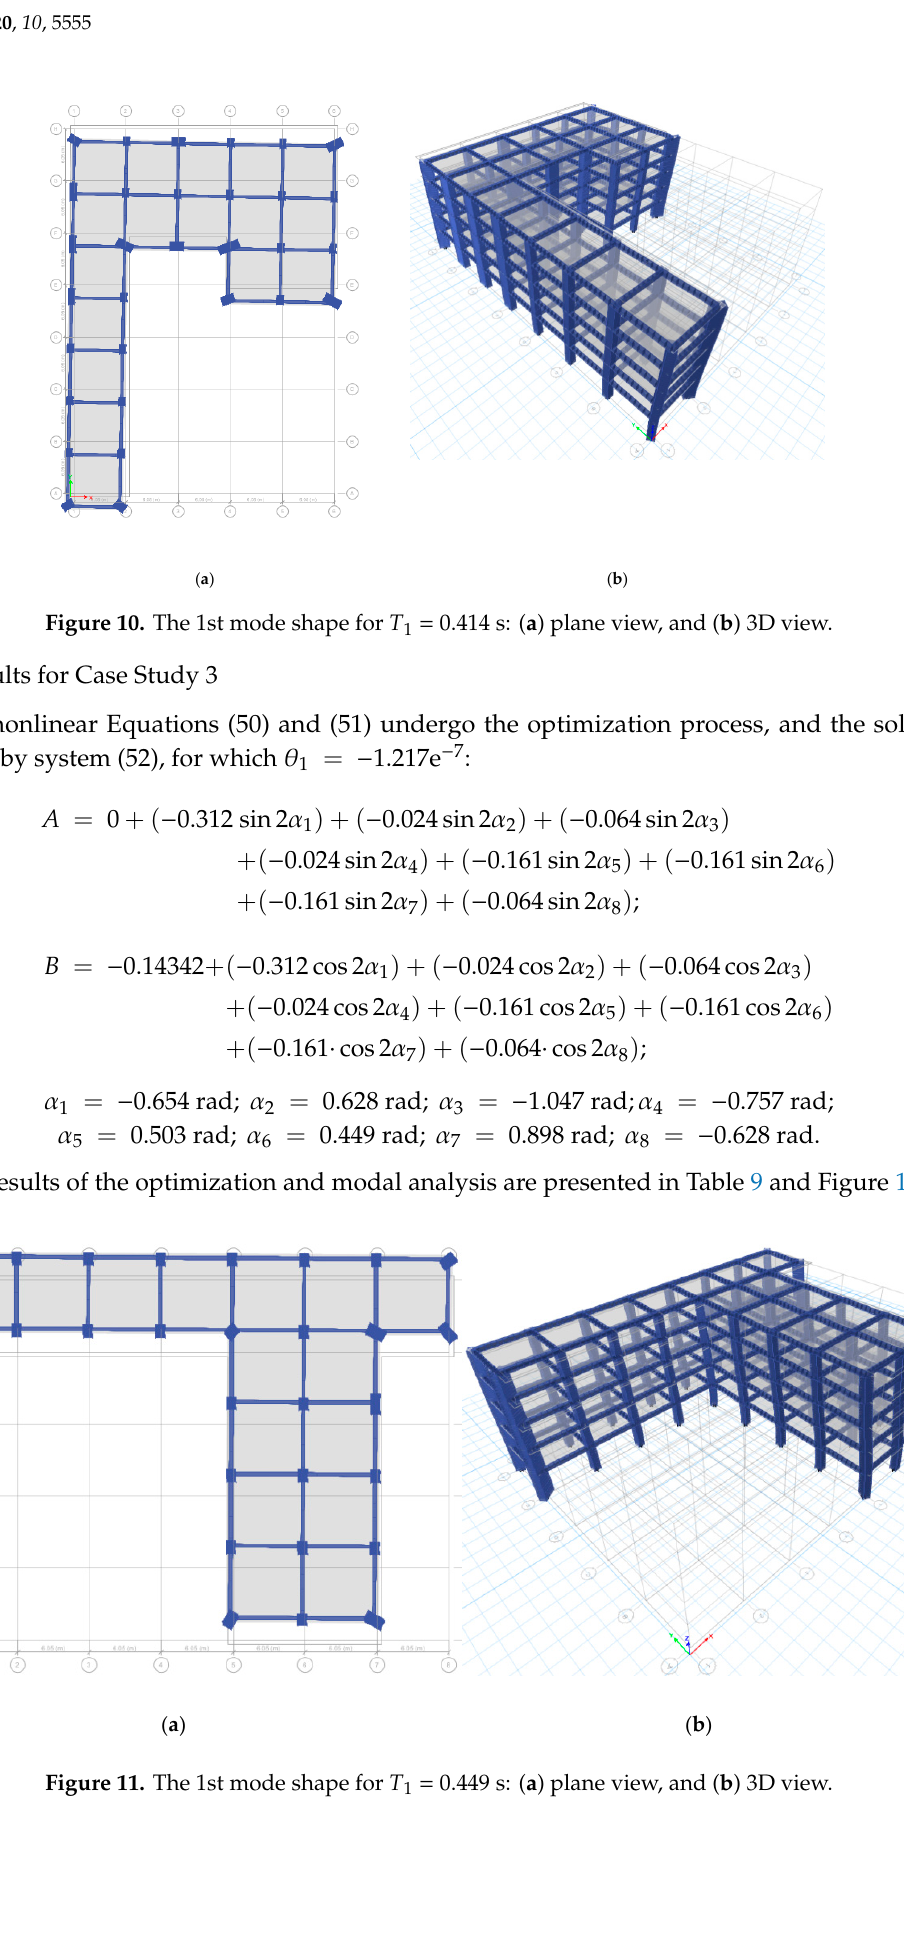
Table 8. Ratios of the modal participating mass after the reducing of the torsion.